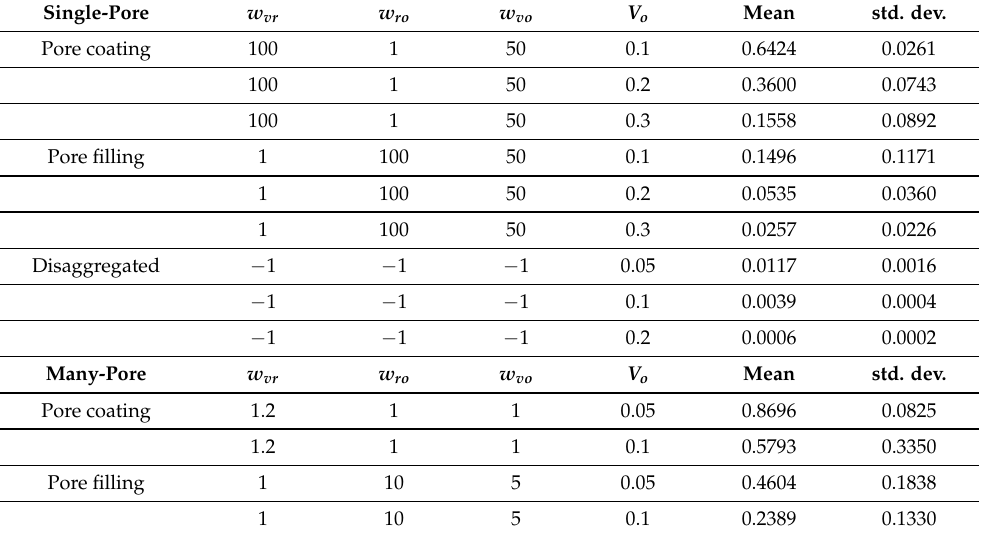
Table 6. Sensitivity of the probability distribution of K ( i ) / K 0 to the simulation parameters of the LP model on the single-pore and many-pore geometries. The mean and standard deviation of K are presented for several selected vales of the relative volume V o = | D o | geometry and V o = 0.1, the method LP generates 20 out of I = 100 impermeable geometries. For V o = 0.15, most are impermeable. These facts result in a large standard deviation, and these results are not